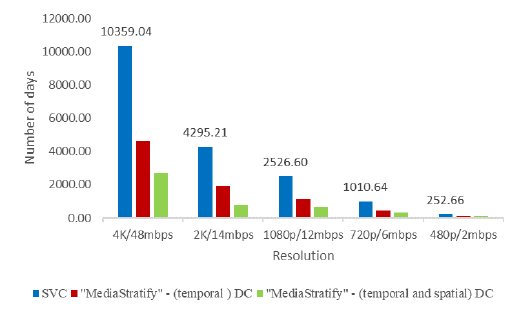
Figure 10. Download time comparison, "MediaStratify" vs SVC for contents in [6]